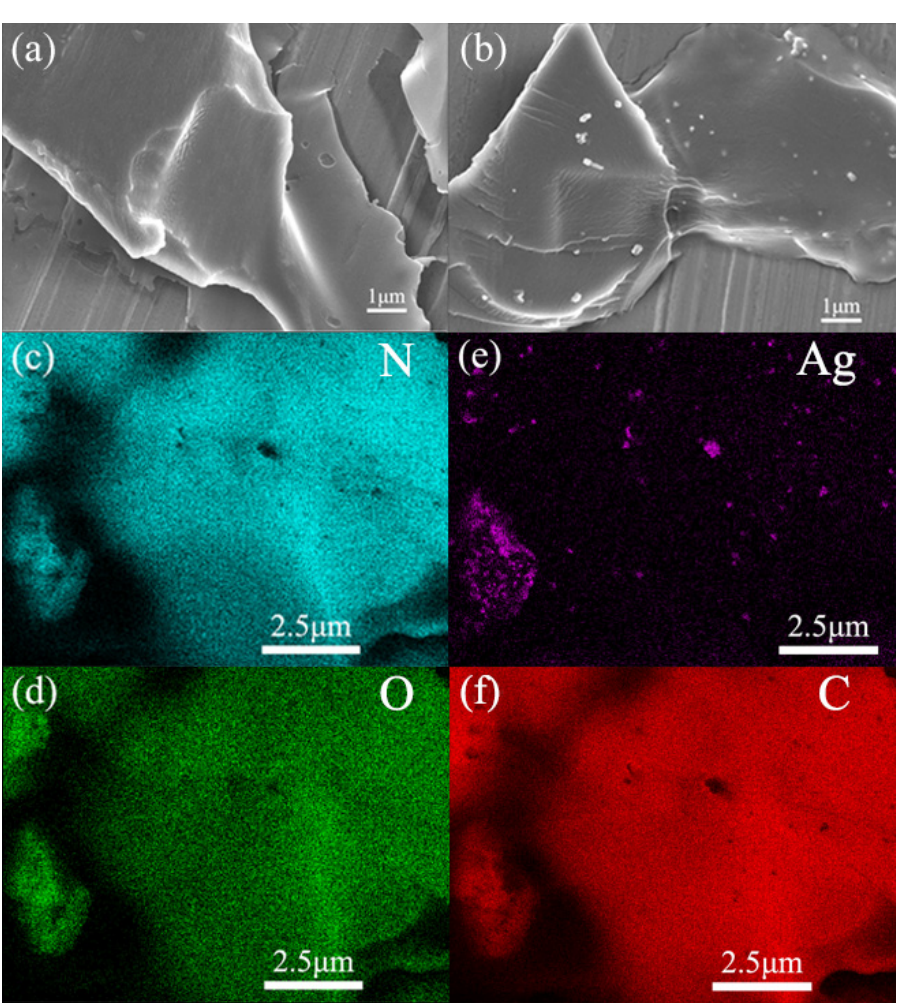
Figure 5. FESEM images of CD-CA/PDA ( a ) and CD-CA/PDA-0.5Ag ( b ); FESEM-EDS element mapping of N ( c ), O ( d ), Ag ( e ) and C ( f ) in CD-CA/PDA-0.5Ag.